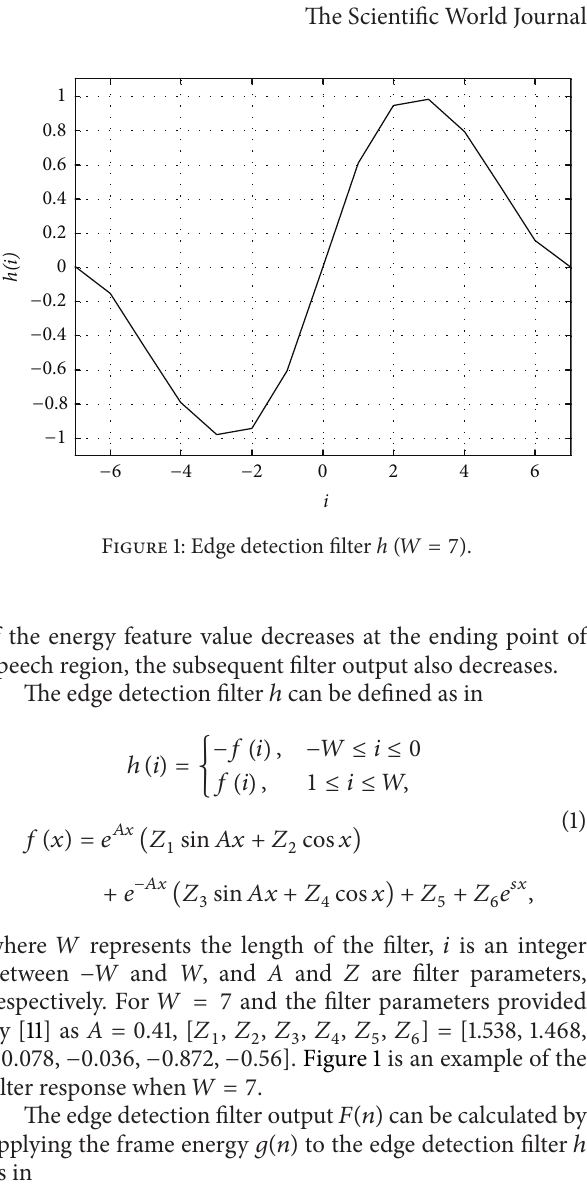
algorithm based on edge detection filter and state transition